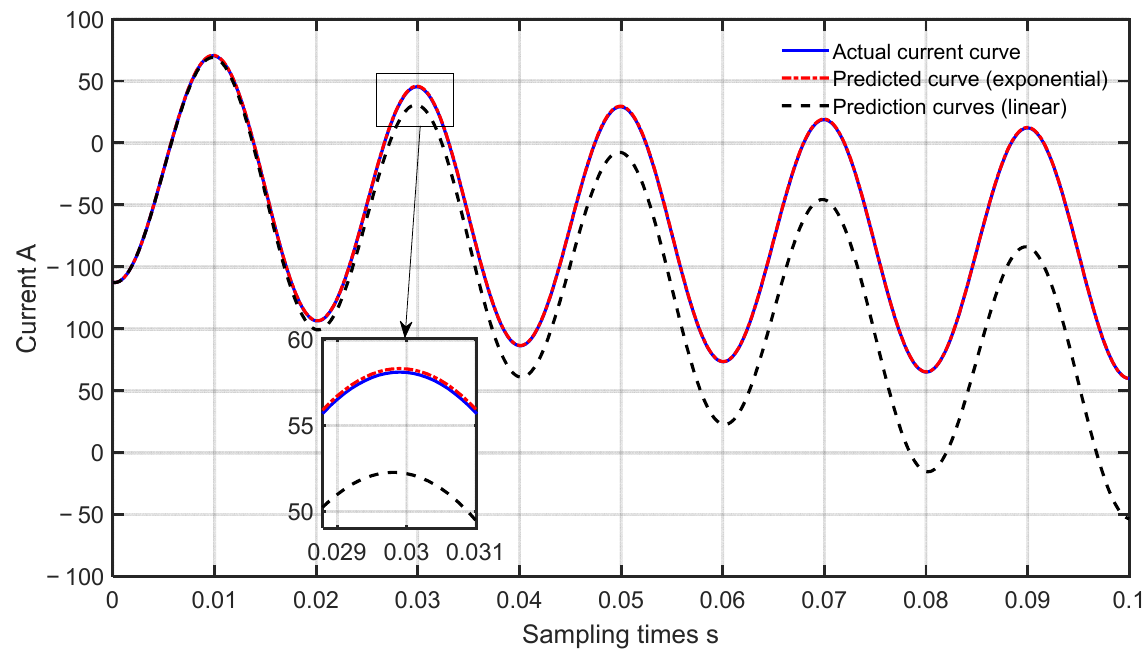
Figure 3. Comparison of predicted and actual curves.